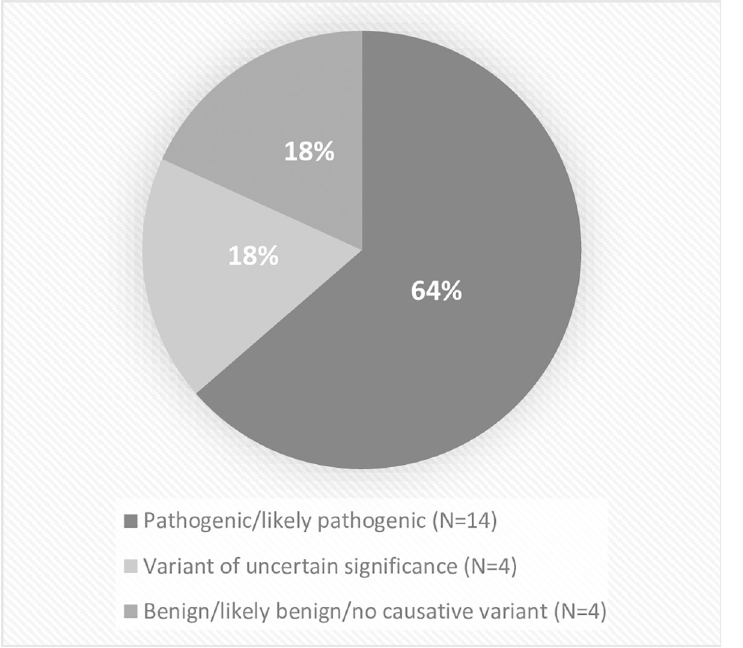
Fig 1. Interpretation of detected genetic variants in paediatric